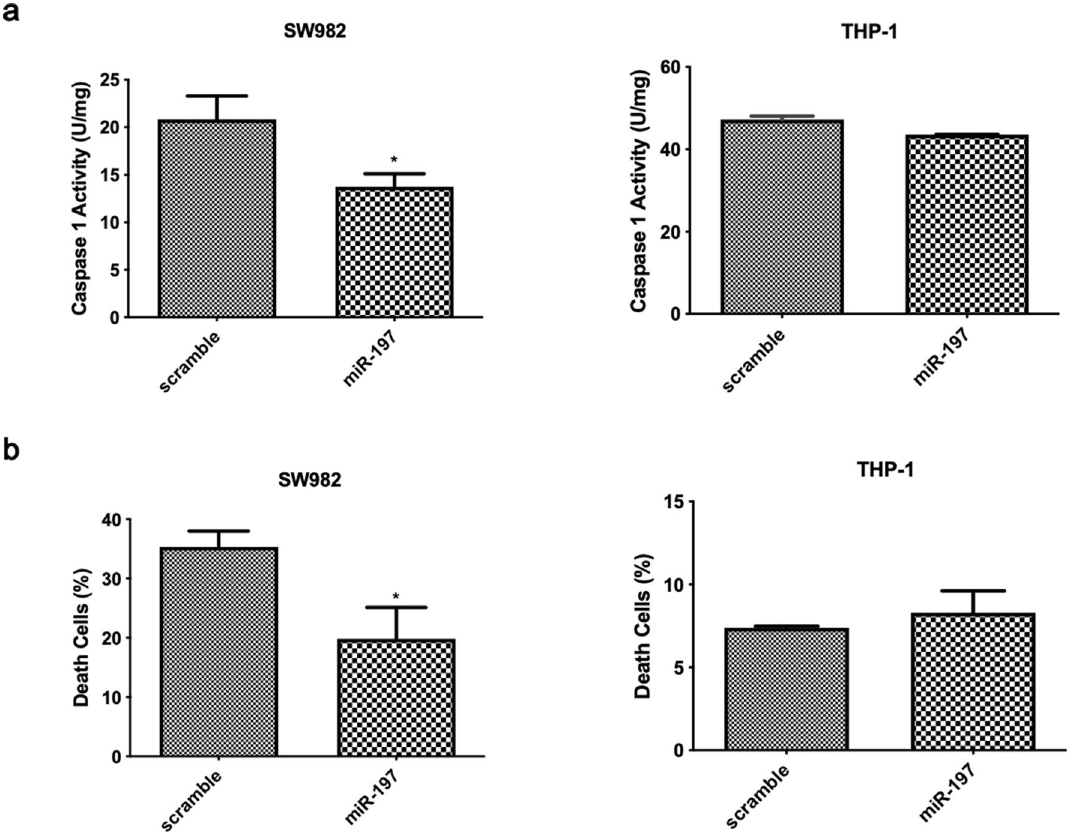
Figure 4. miR-197-3p suppresses caspase-1 activity and apoptosis. (a) Caspase-1 activity in miR-197-3p or control sequence-transfected (scramble/mimic control) SW982 and THP-1 cell lines. Data represent the mean ± standard deviation from three independent experiments. * P < 0.05, Student’s t-test (two-tailed). ( b) Apoptosis rate as a death cell in percentage in miR-197-3p or control sequence-transfected (scramble/mimic control) SW982 and THP-1 cell lines. Data represent the mean ± standard deviation from three independent experiments. * P < 0.05, Student’s t-test